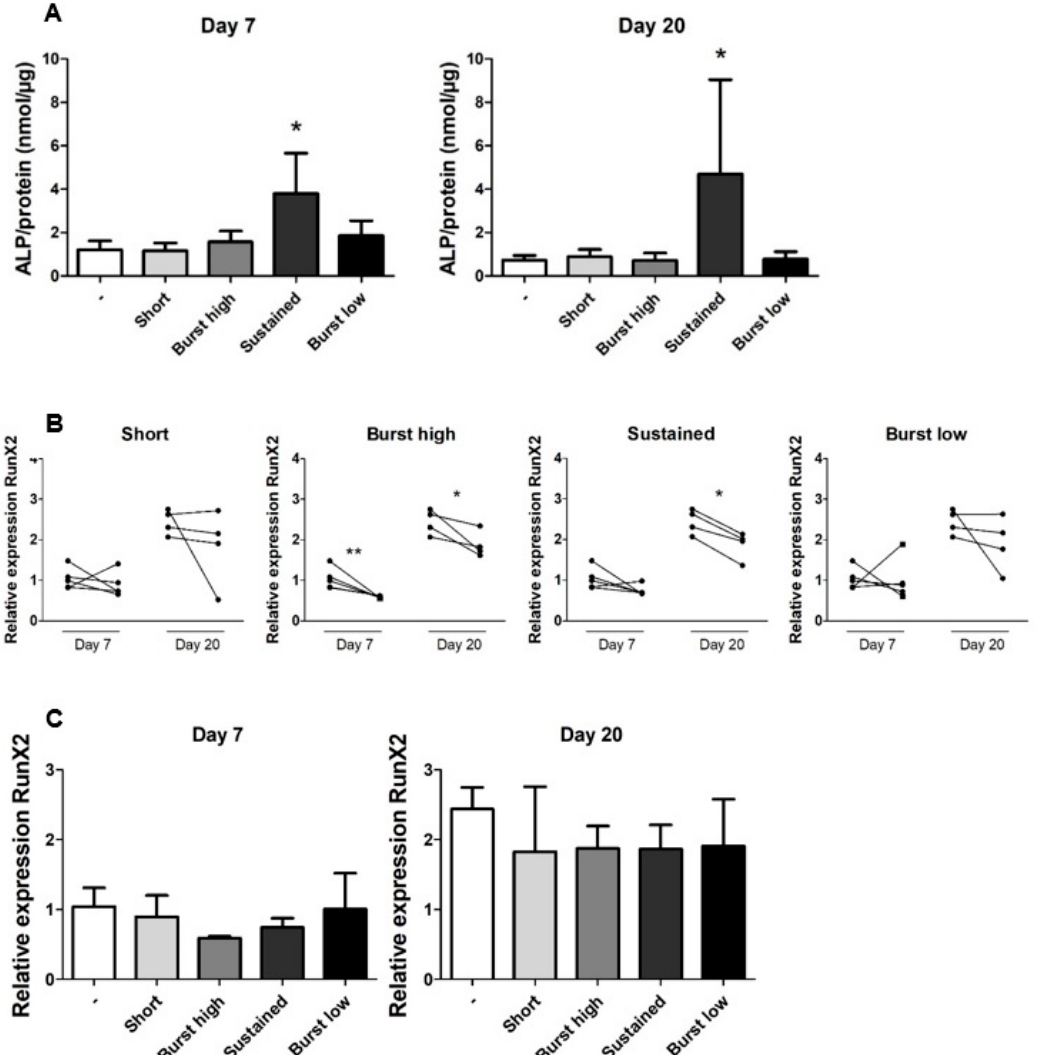
Figure 4. E ff ect of vitamin D 3 on ALP activity and RUNX2 expression. ( A ) Cellular ALP, as a measure for early osteogenic di ff erentiation, was measured on Days 7 and 20. Sustained-release significantly increased ALP activity compared to all other groups at both time points. ( B ) RUNX2 expression in general seemed to be higher at Day 20 compared to Day 7, although no statistical comparison was made. VitD 3 seemed to reduce RUNX2 expression in general. This effect of vitD 3 was significant for burst high at Days 7 and 2, and for sustained application at Day 20. Gene expression in controls (left) and vitD 3 -treated cultures (right) of the same donor are connected by a line. ( C ) Average relative expression of RUNX2 at Days 7 and 20. Data represent four or five independent donors (mean + SD). All gene expression levels were normalized to HPRT . * Significant difference ( p < 0.05) between control and vitD 3 treatment at the same time point ** p < 0.01.